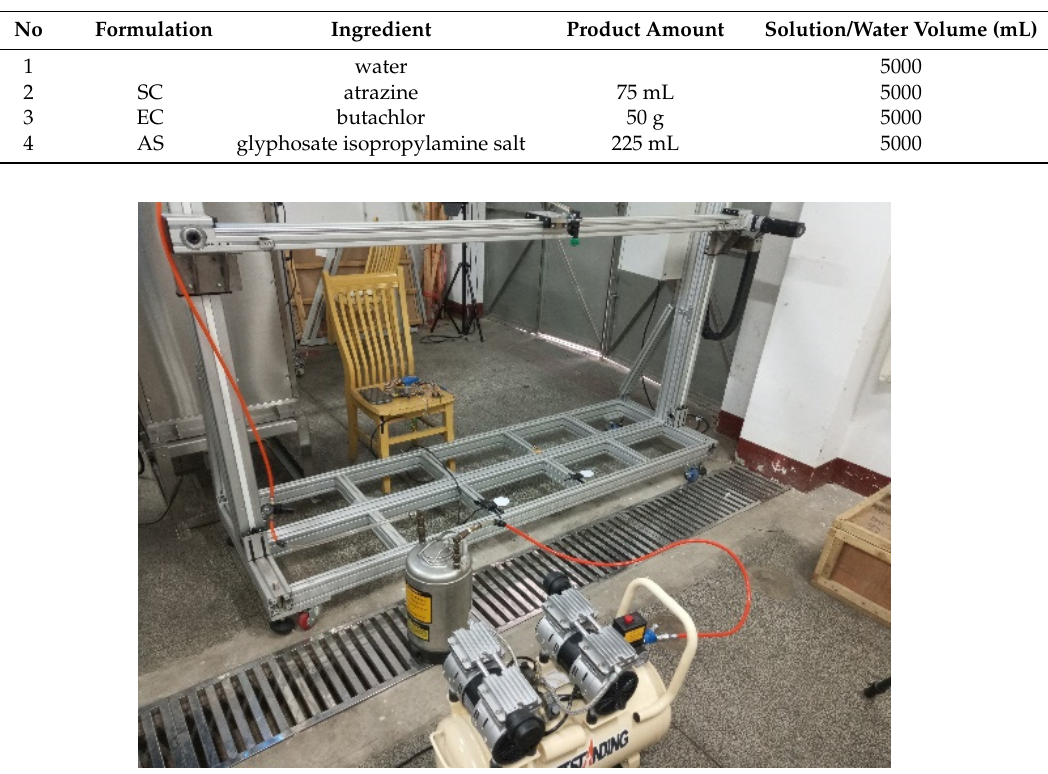
Figure 2. The hanging orbit sprayer for herbicide application in the experiment.